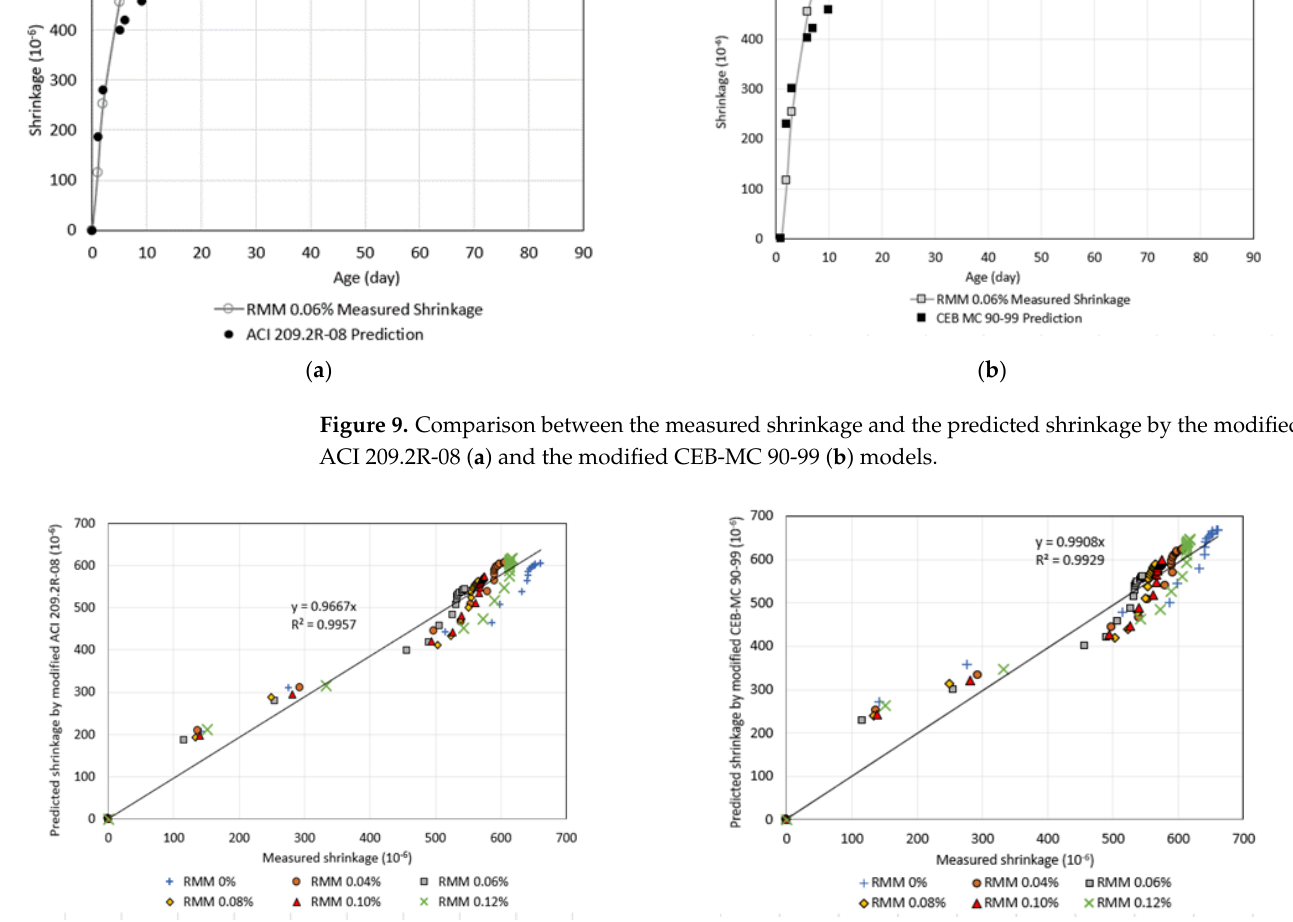
( b ) Figure 11. Evaluation of the modified ACI 209.2R-08 ( a ) and the modified CEB-MC 90-99 ( b ) models by residual analysis. Table 4. Summary of quantitative evaluation of the modified and original prediction models. Method